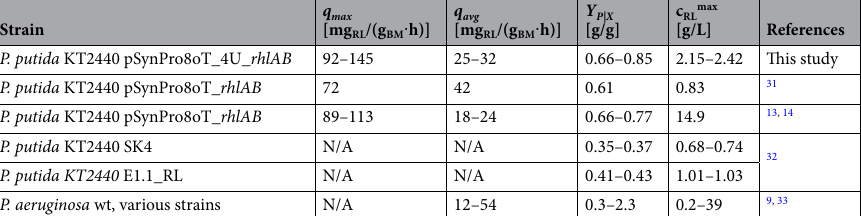
Table 1. Comparison of rhamnolipid production processes from literature using glucose as carbon source with the presented switch process (Fig. 5). N/A = Information not available; c RLmax = Maximum rhamnolipid